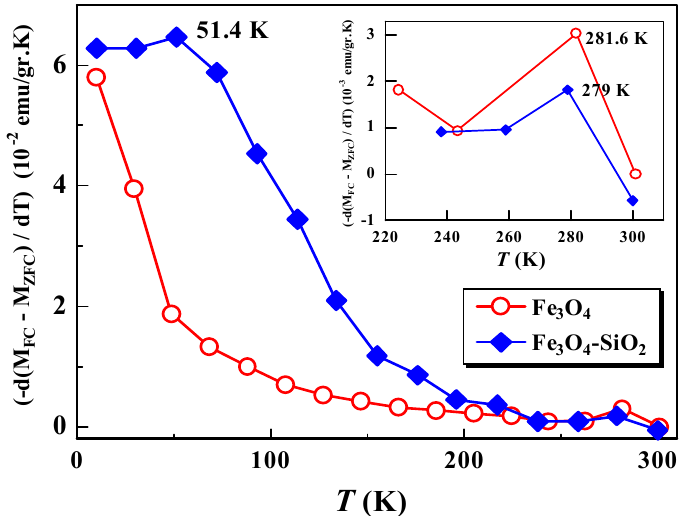
Figure 5. Temperature derivative [ − d ( M FC − M ZFC ) / dT ] of the difference between FC and ZFC magnetizations for samples Fe 3 O 4 and Fe 3 O 4 -SiO 2 .